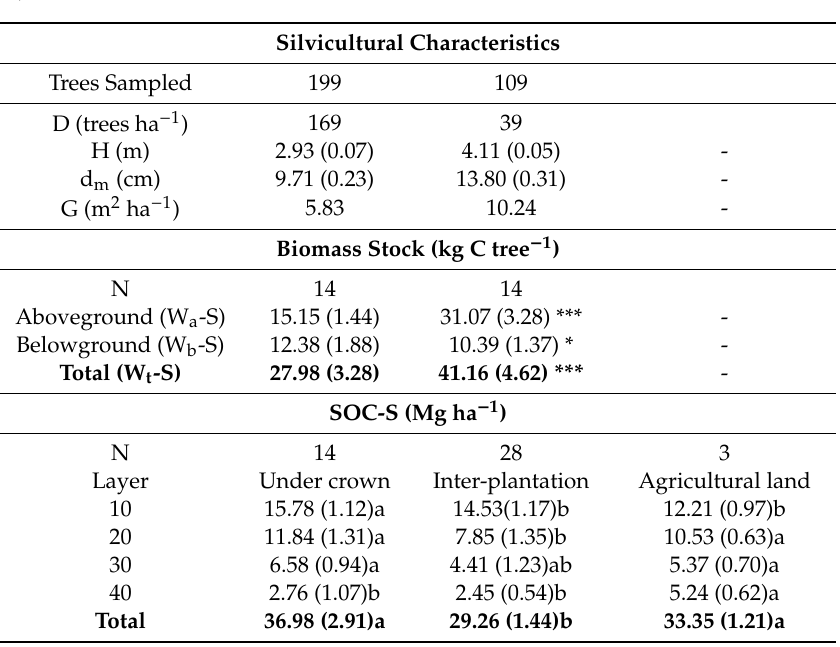
Table 1. Silvicultural characteristics, biomass and soil organic carbon stocks of the Quercus ilex-Q. suber plantation at Puebla de Guzm á n (Huelva, Southwestern Spain). Variables and abbreviations: stem density (D, trees ha − 1 ); total height (H, m); quadratic mean diameter (d m , cm); basal area (G, m 2 ha − 1 ); biomass C stock (W t , Mg ha − 1 ) and soil organic carbon stock (SOC depth –S, Mg ha − 1 ). Values are means ± standard error (SE). Di ff erent letters indicate significant post-hoc test di ff erences between treatments at alpha = 0.05, based on a one-way analysis of variance (ANOVA). Student’s t -test, * P < 0.05, ** P < 0.01, *** P <